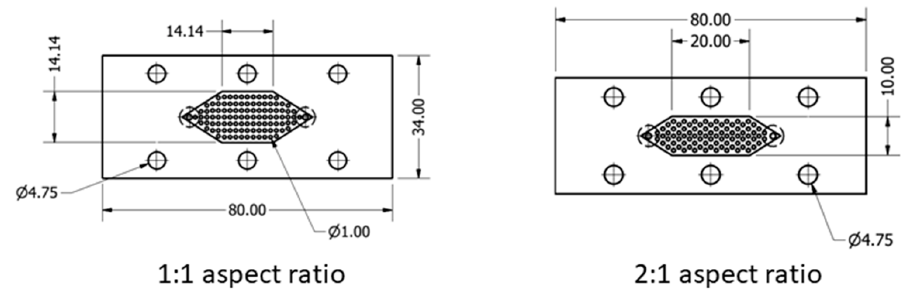
Figure 5. Tapered channel distributors used in cuboid packed-bed devices.